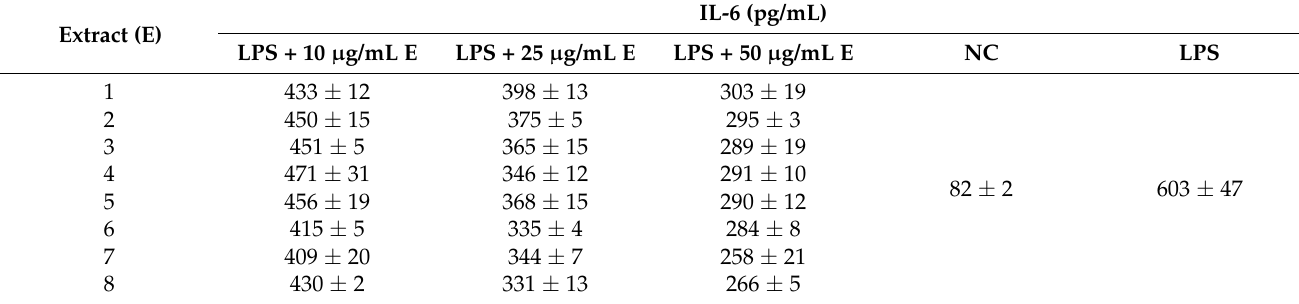
Table 10. The anti-inflammatory potential of Epilobium sp. extracts. The quantity of IL-6 was measured from cellular supernatants after a 24 h exposure to the extracts (10, 25, and 50 µ g/mL) in combination with 100 ng/mL LPS. Data are expressed as mean ± standard deviation of three biological